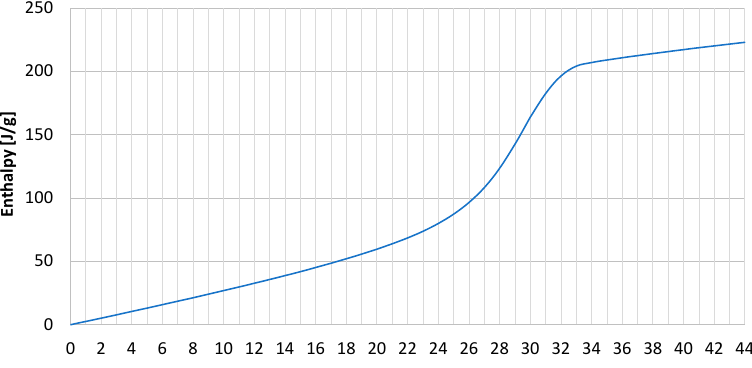
Figure 3. Enthalpy variation with temperature for Micronal ® DS 5001 X.